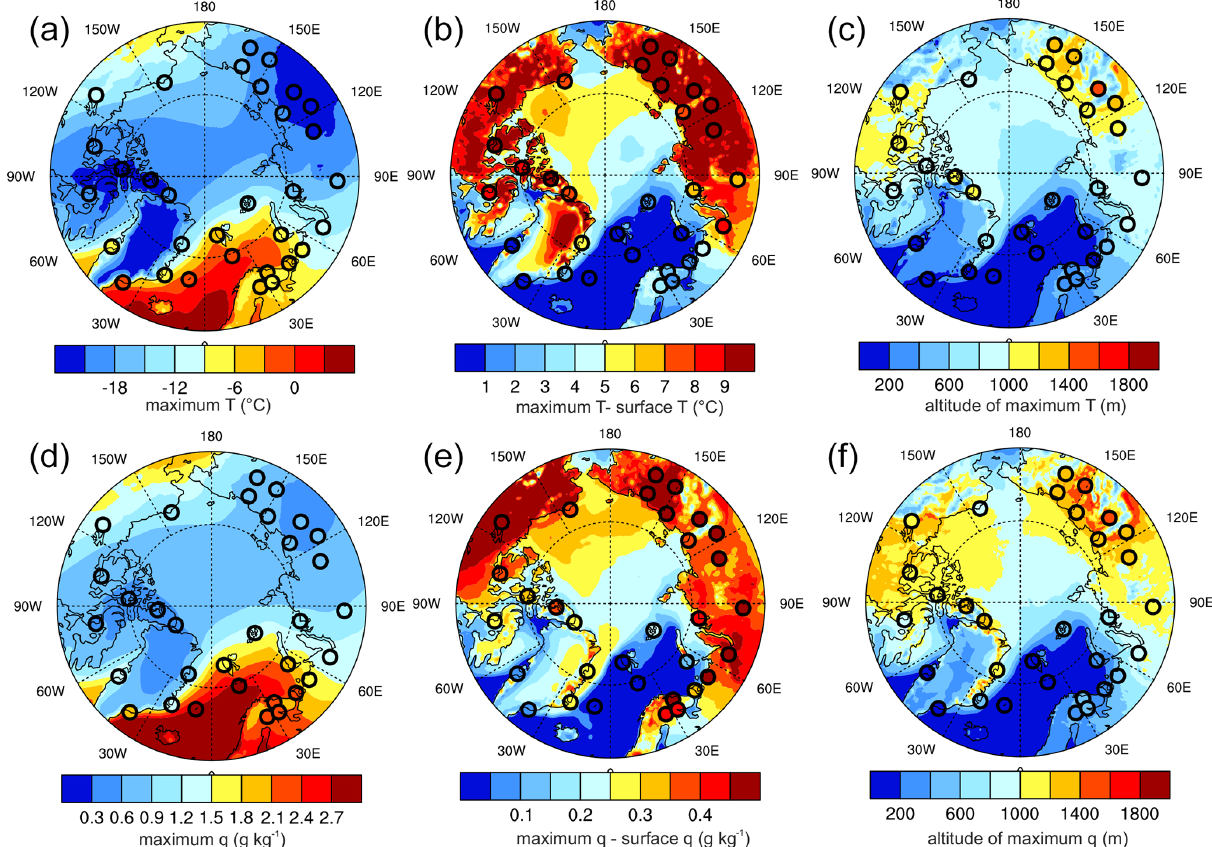
Figure 5. Medians of (a) vertical maximum T , (b) vertical maximum T − surface T (bulk inversion strength), (c) altitude of vertical max- imum T , (d) vertical maximum q , (e) vertical maximum q − surface q (bulk inversion strength) and (f) altitude of vertical maximum q in December–February 2009–2018. The colours inside the circles show values based on radiosonde observations, whereas the fields are based on